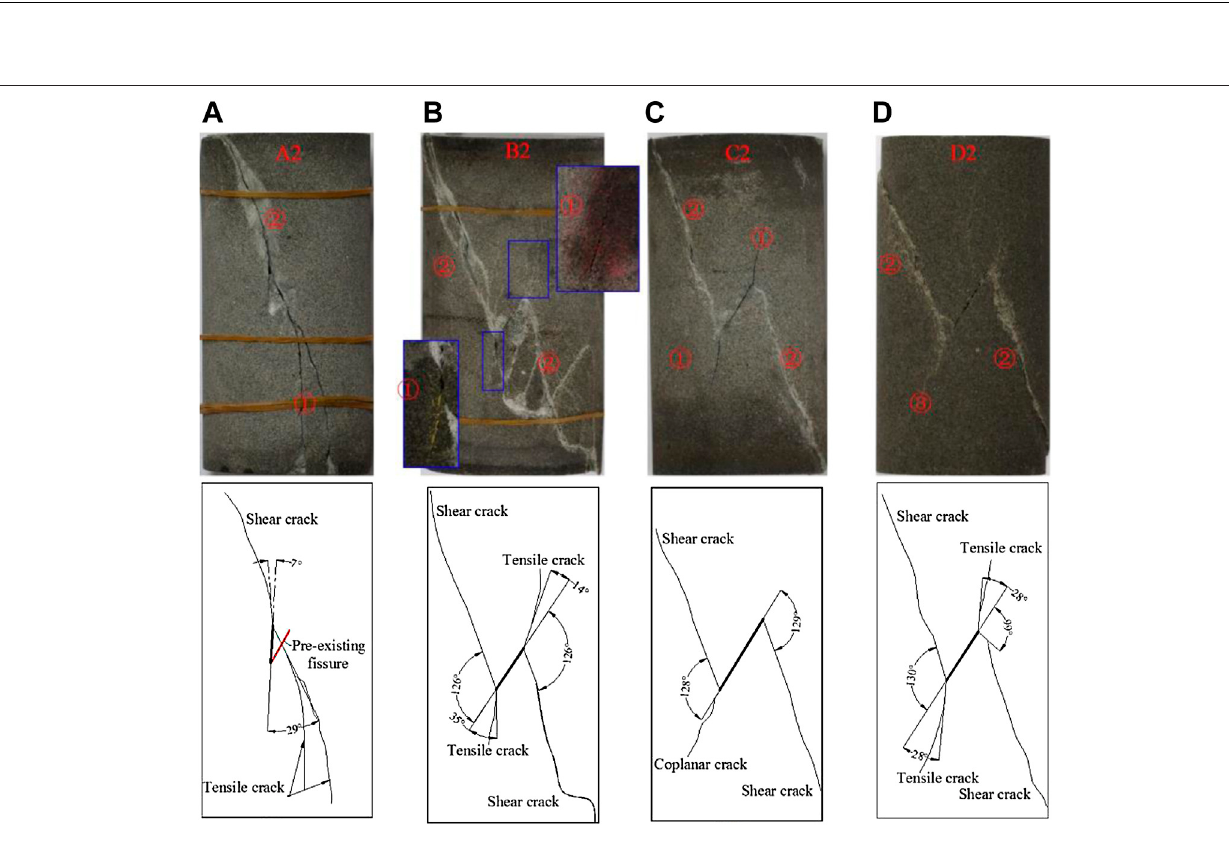
Frontiers in Earth Science |